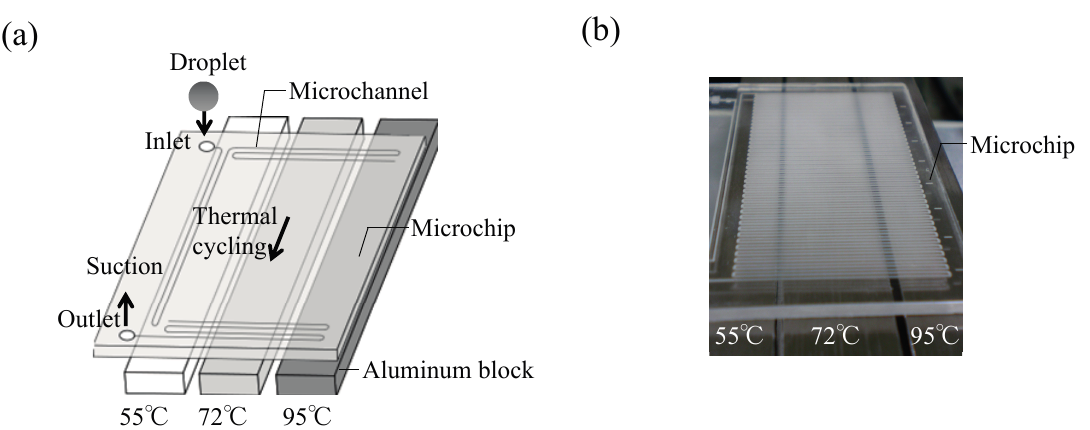
Figure 1. A flow-through PCR microfluidics device made by applying pressure-sensitive adhesive (PSA) film on cyclo-olefin polymer (COP) substrate: ( a ) Diagrammatic illustration of liquid plug-flow PCR microfluidic device; ( b ) Photo of the flow-through PCR microfluidic device.